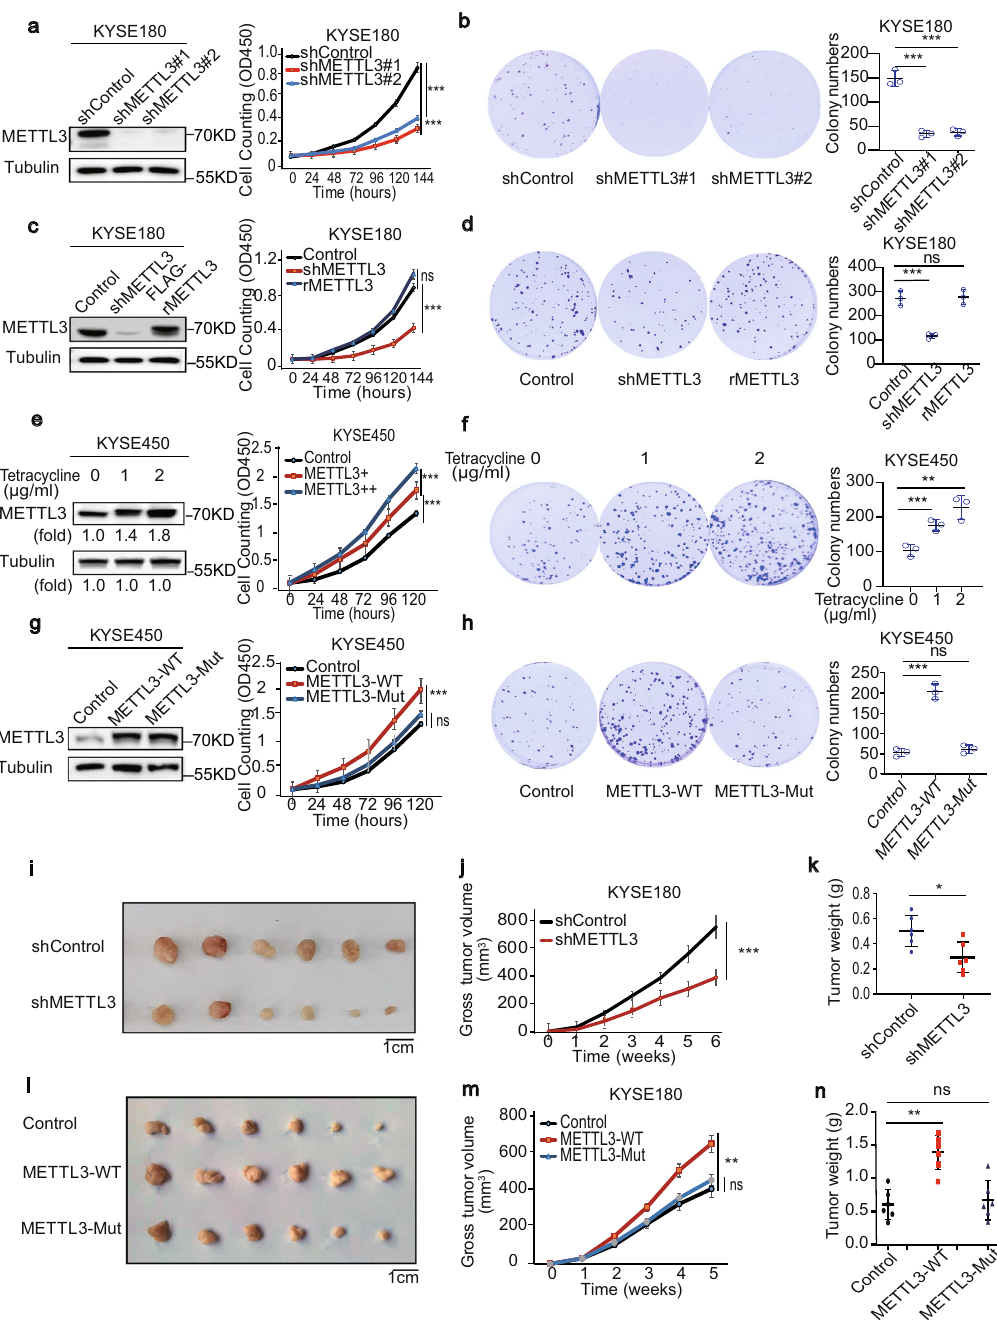
Fig. 2 METTL3 promotes ESCC cell proliferation and tumour growth in mice. a – d KYSE180 cells with or without METTL3 depletion ( a ), or with reconstituted expression of an RNAi-resistant (r) METTL3 ( c ) were analysed by immunoblotting analyses. The cell proliferation ( a , c ) and colony formation ( b , d ) assays were performed. Data represent means ± SD of triplicate samples. a *** p = 0.0004 (top), 0.0002 (bottom). b *** p = 0. 0004 (left), 0.0004 (right) (two-tailed t -test). c *** p = 4.72E − 05. d *** p = 0.0007. Two-tailed t -test; ns, not signi fi cant. e , f KYSE450 cells expressing the METTL3 expression-inducible Tet-on lentiviral vector were treated with or without the indicated dosages of tetracycline, followed by immunoblotting analyses. The cell proliferation ( e ) and colony formation ( f ) assays were performed. Data represent means ± SD of triplicate samples. e *** p = 6.37E − 04 (top), *** p = 9.58E − 04 (bottom). f *** p = 9.24E − 04 (left), ** p = 0.0095 (right). Two-tailed t -test. g , h KYSE450 cells with or without expressing WT METTL3 or an inactive METTL3 mutant were analysed by immunoblotting analyses. The cell proliferation ( g ) and colony formation ( h ) assays were performed. Data represent means ± SD of triplicate samples. *** p = 0.0004 ( g ), *** p = 0.0003 ( h ). Two-tailed t -test; ns, not signi fi cant. i – k KYSE180 cells with or without METTL3 depletion were subcutaneously injected into the mice ( n = 6). Six weeks later, tumour sizes ( i ), volumes ( j ) and weight ( k ) were measured. Scale bar, 1 cm. Data represent means± SD of six mice per group. *** p = 2.58E − 06 ( j ), * p = 0.0138 ( k ) (two-tailed t -test). l – n KYSE180 cells with or without expressing WT METTL3 or an inactive METTL3 mutant were subcutaneously injected into the mice ( n = 6). Five weeks later, tumour sizes ( l ), volumes ( m ) and weight ( n ) were measured. Scale bar, 1 cm. Data represent means ± SD of six mice per group. ** p = 0.0015 ( m ), 0.0013 ( n ) (two-tailed t -test). ns, not signi fi cant. Source data are provided as a Source Data fi